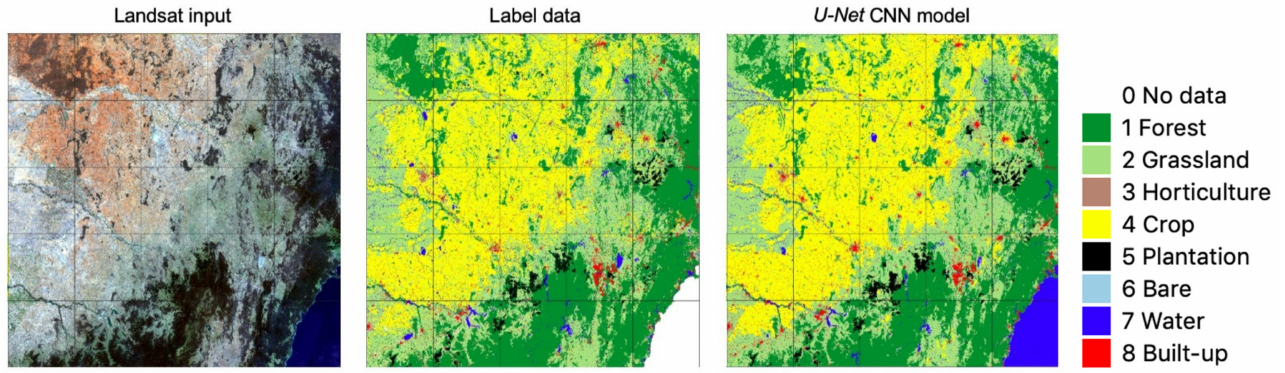
Figure 8. U-Net CNN model compared with label data and Landsat input (true colour RGB) for the study area (~500 km × 500 km).